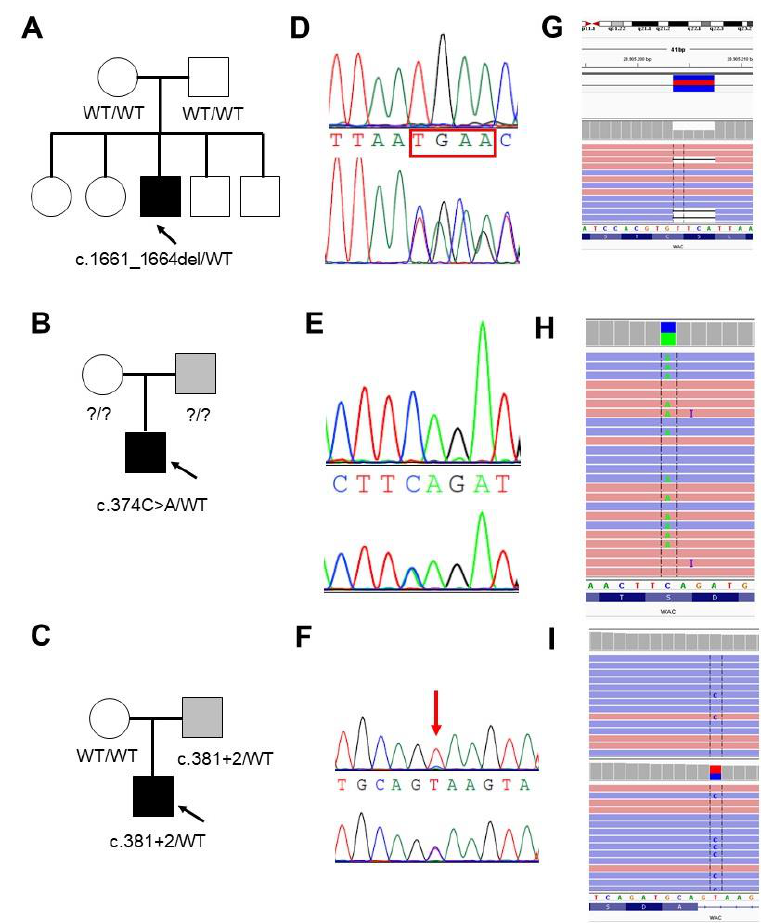
Figure 2. Validation and segregation analysis of the three LoF WAC mutations. ( A – C ) Pedigrees of Family 1, 2 and 3, respectively. Probands are indicated with an arrow. ( D – F ) Electropherograms of the mutated positions (bottom) compared to the wild-type sequence (upper) ( D , E ) or to the mosaic father (upper) ( F ). ( G – I ) Screen shot from the Integrative Genomic Viewer (IGV) [18] visualization showing part of the reads at the mutated positions. ( I ) Reads show the presence of mosaicism (43 / 330; 12%) for the c.381 + 2T > C in the father evaluated in the DNA sample from oral mucosa (upper) compared to the proband (15 / 21; 42%) (bottom).